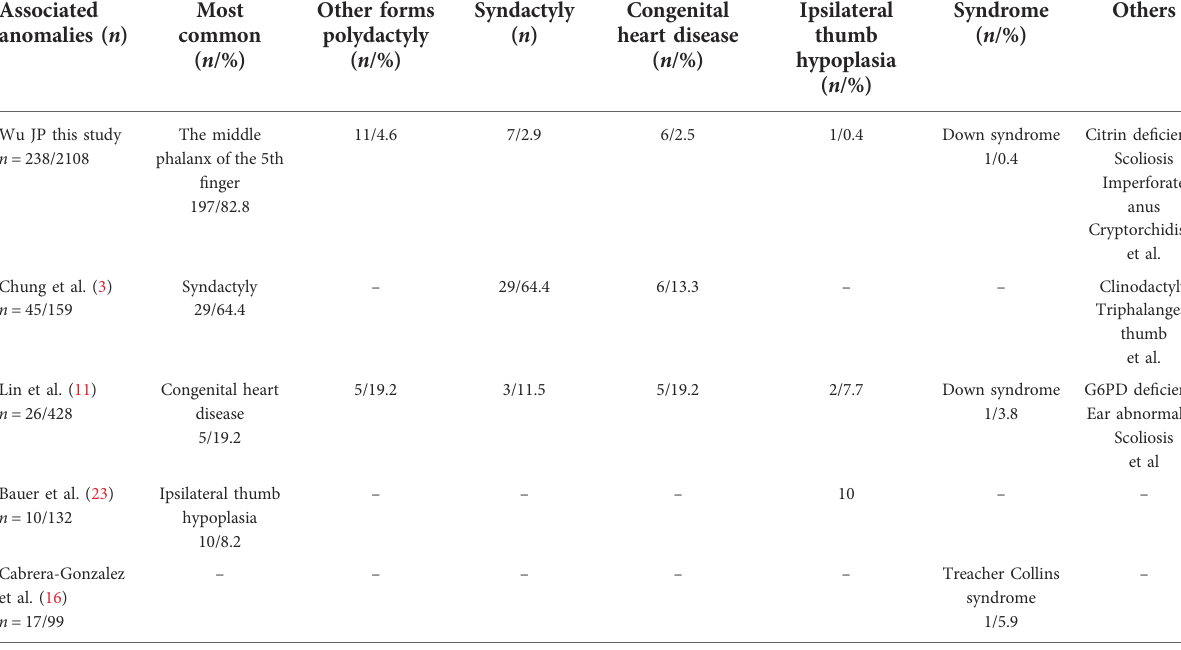
TABLE 3 Previous studies about association between congenital anomalies and CTD. Associated anomalies ( n